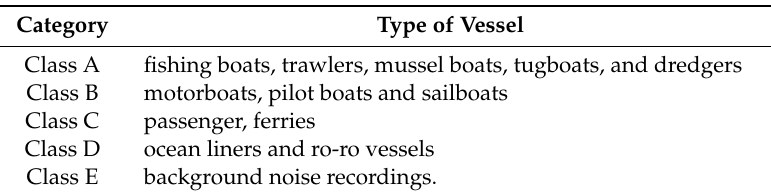
Table 5. Data classification in ShipsEar.